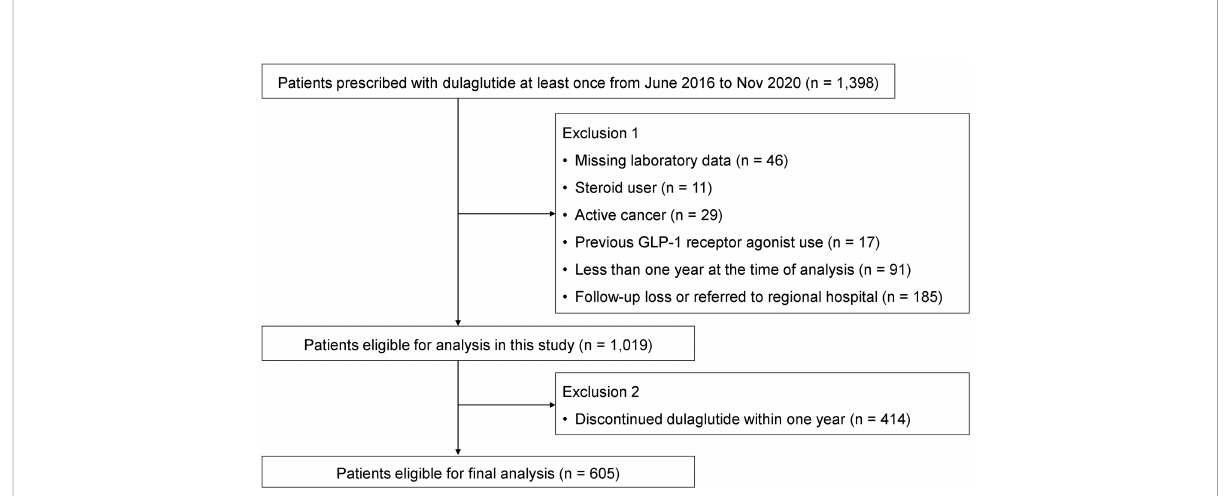
FIGURE 1 Flow diagram showing the selection process of the study population for durability of